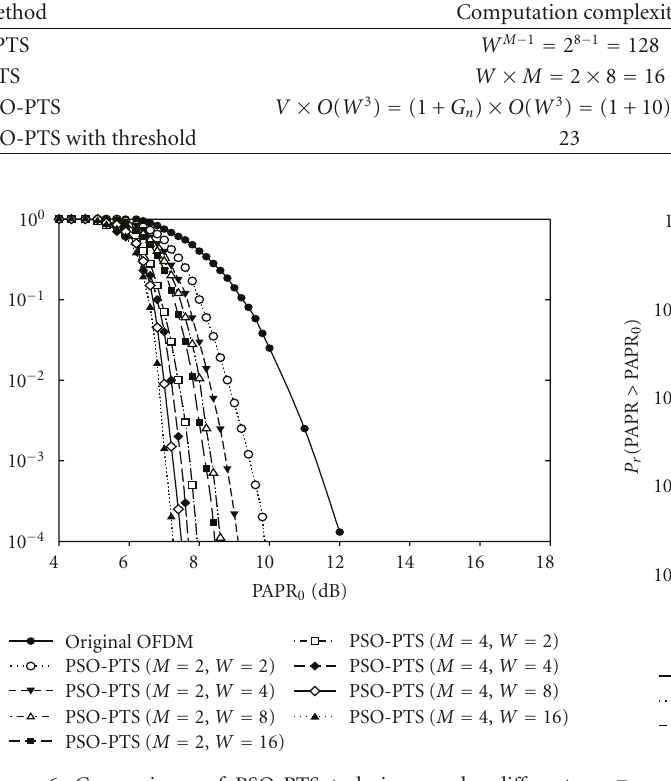
Figure 7: Comparison of the PSO-PTS technique with threshold PAPR, iterative PTS, PSO-PTS, and OPTS methods when M = 8.